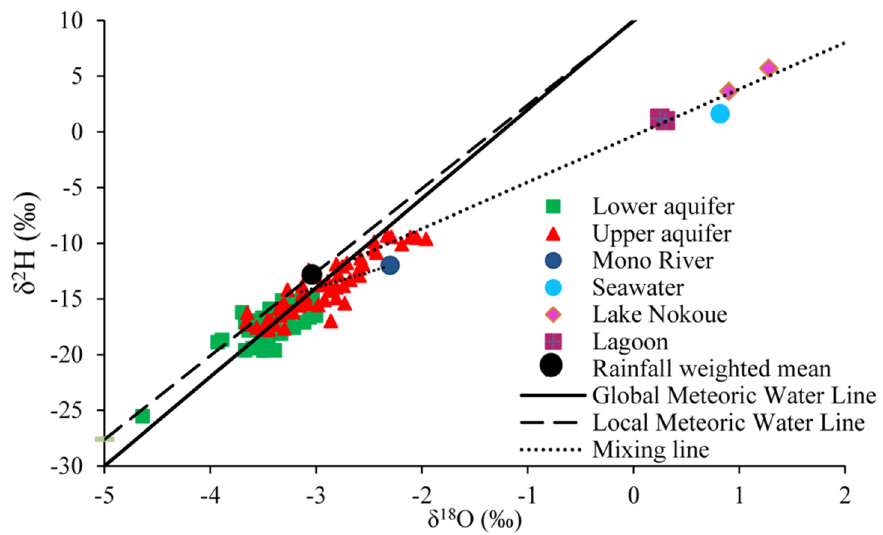
Figure 5. Stable isotope compositions of groundwater in the coastal area of Benin. The isotope contents of Mono River, Lake Nokoué, local lagoons, and seawater are also plotted as well as the Local Meteoric Water Line ( δ 2 H = 7.5 δ 18 O + 10), the Global Meteoric Water Line ( δ 2 H = 8 δ 18 O + 10), the lines showing trends of mixing between ground and surface waters, and also the weighted mean rainfall composition.